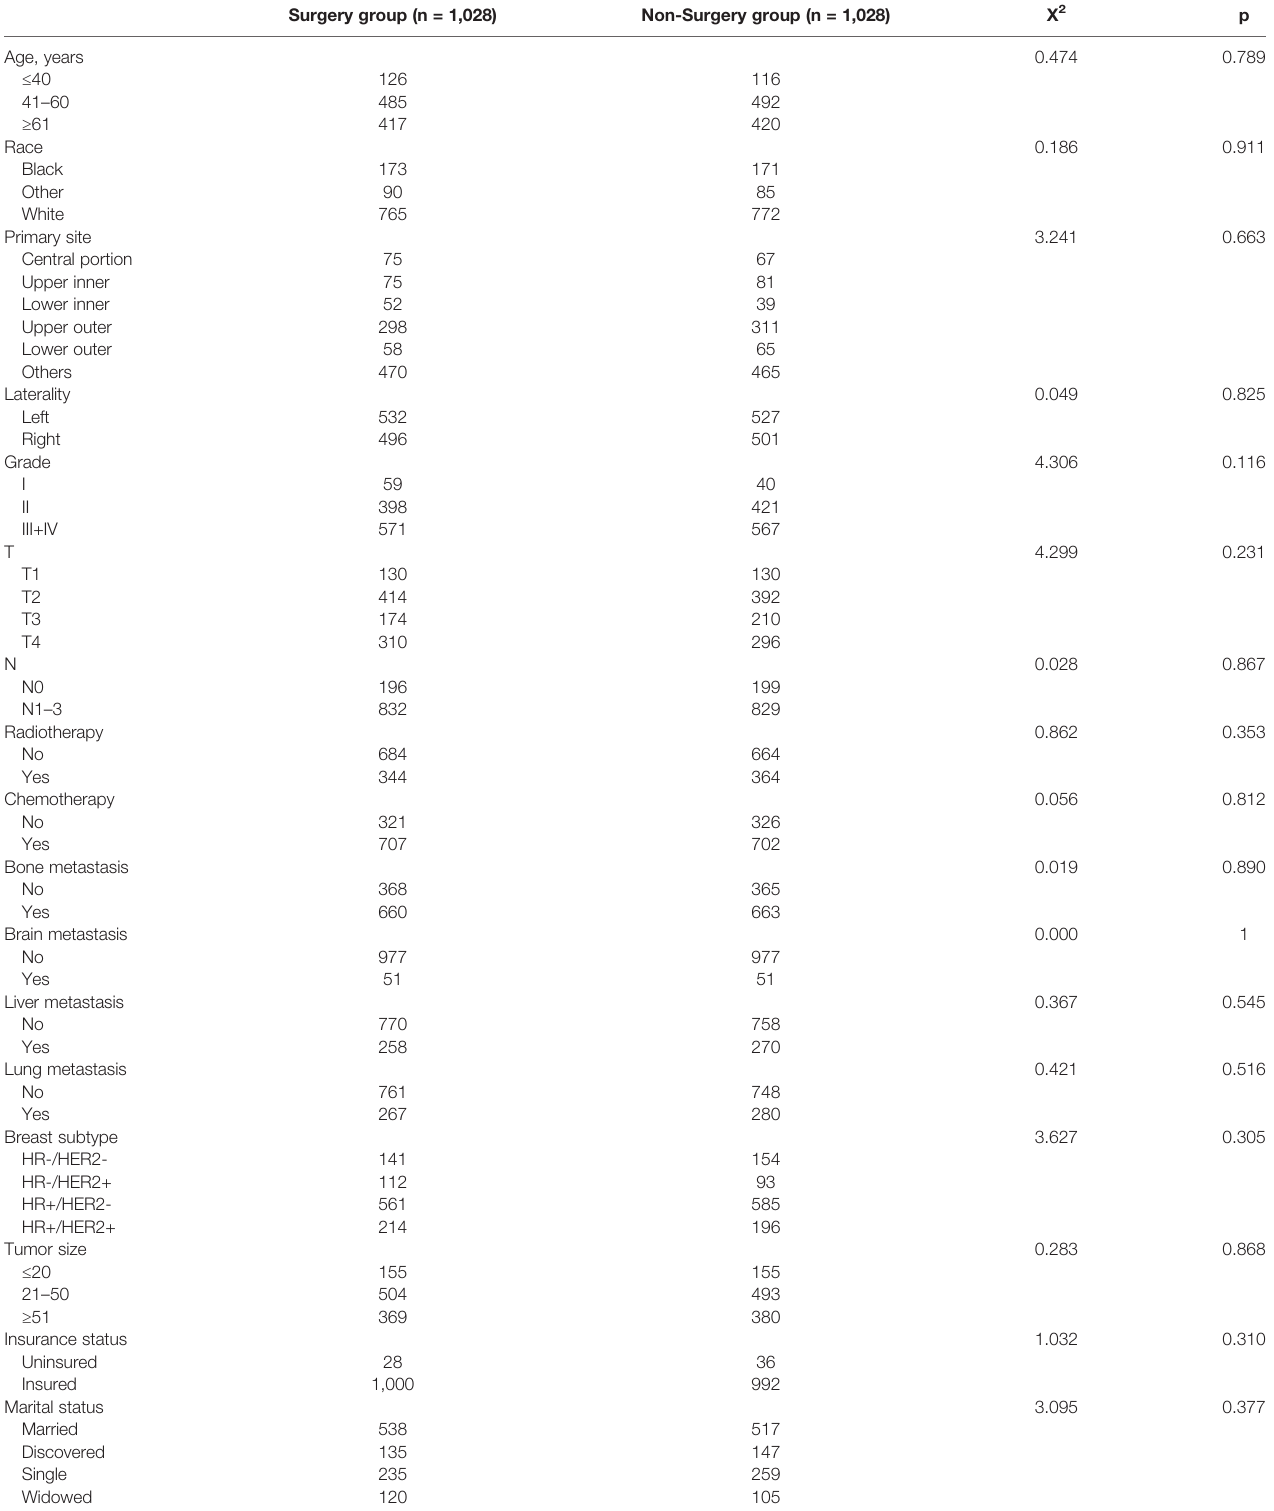
TABLE 2 | Clinical and pathological characteristics for female patients with stage IV IDC of breast after